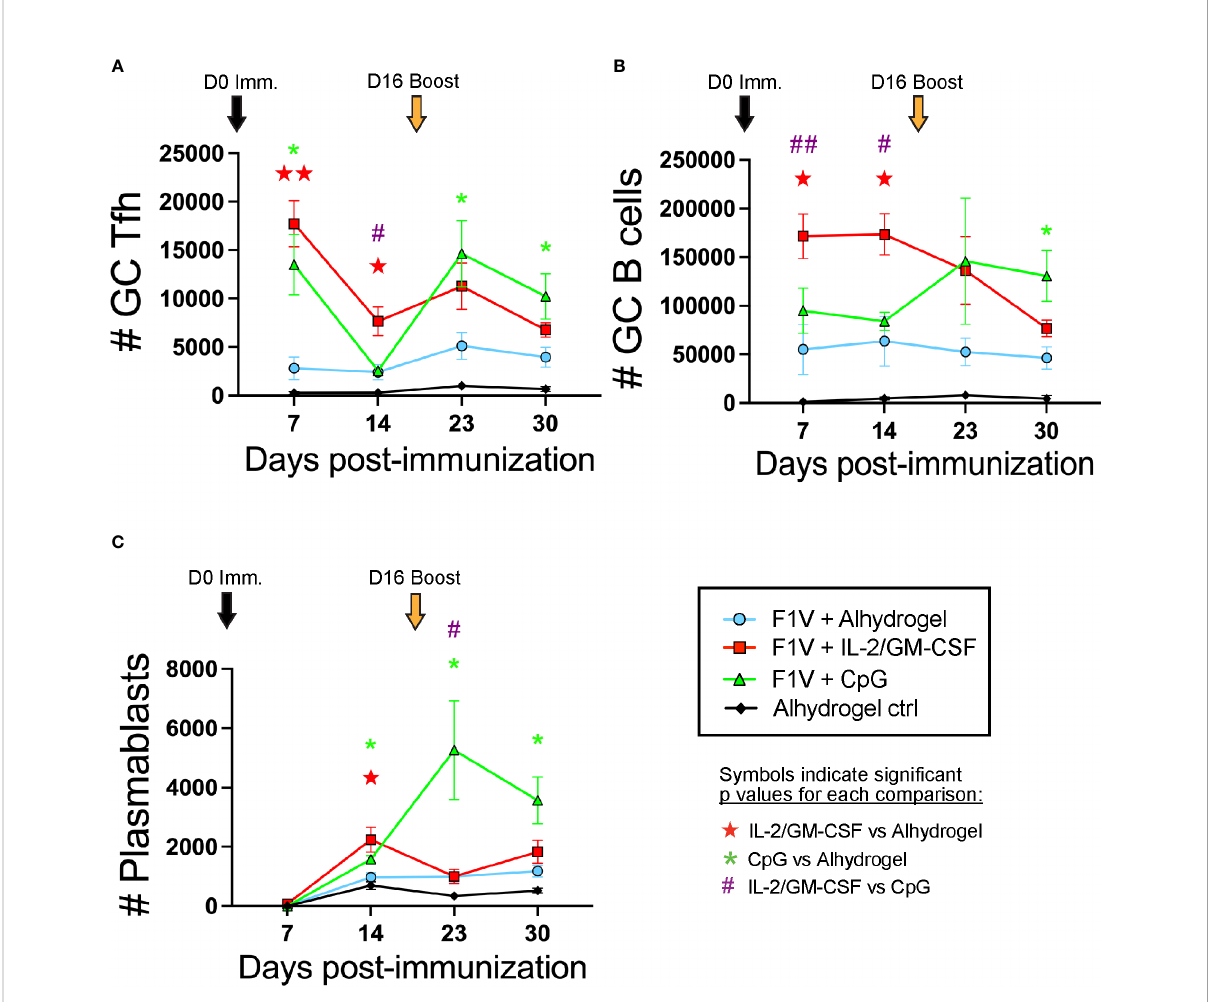
FIGURE 5 CpG and IL-2/GM-CSF as adjuvants differentially alter the magnitude and duration of the germinal center response following F1V primary and booster immunization. Mice were immunized on day 0 and given booster shots on day 16. Draining lymph nodes were collected for germinal center analysis on days 7, 14, 23, and 30 post-immunization. (A) Number of CXCR5+Bcl6+ GC Tfh cells. (B) Number of CD19+Fas+PNA+ GC B cells. (C) Number of CD19+IgD-CD138+ plasmablasts. n=5 per group per experiment at each time point. Data shown are from one experiment and are representative of two independent experiments. Statistically signi fi cant p values were determined using multiple unpaired Student t test; Colored symbols (red star, green asterisk, or purple hashtag) indicate signi fi cant p values for each of the indicated comparisons between experimental groups: one symbol for p < 0.05, two symbols for p <